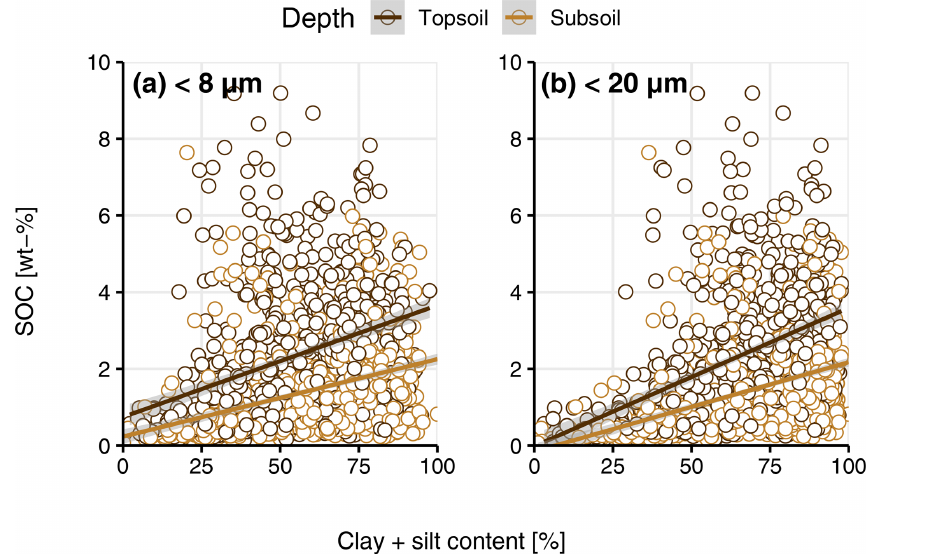
Figure A2. (a) Soil organic carbon (SOC) content (wt%) and clay + fine silt content < 8µm (percent) by depth. (b) SOC content (wt%) clay + fine silt content < 20µm (percent) by depth.